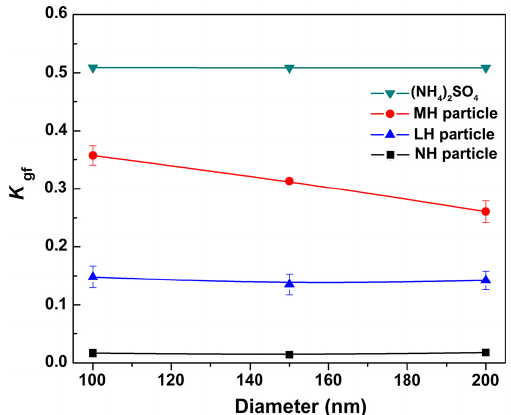
Figure 7. κ results for the 100, 150, and 200nm atmospheric parti- cles at RH on 28 September